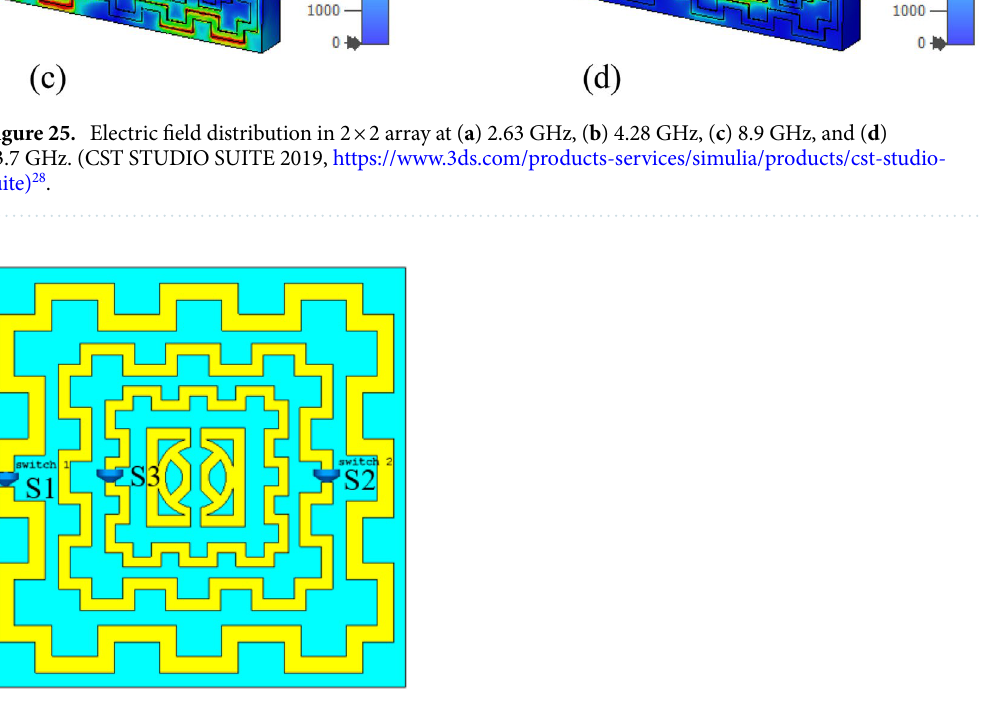
Figure 26. Open and short circuit of the split gaps through the switches S1, S2, and S3. (CST STUDIO SUITE 2019, https:// www. 3ds. com/ produ cts- servi ces/ simul ia/ produ cts/ cst- studio- suite) 28